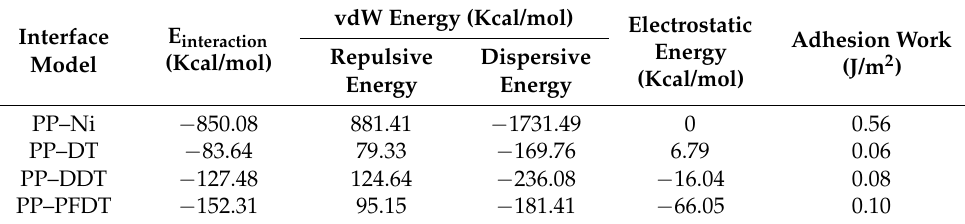
Table 3. Interaction energy and adhesion work in three interface models in P (2 × 2) arrangement.